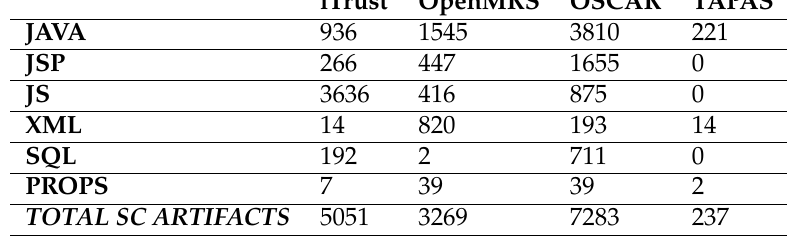
Table 3: Summary of source code files containing source code artifacts that were taken as the corpus of the traceability